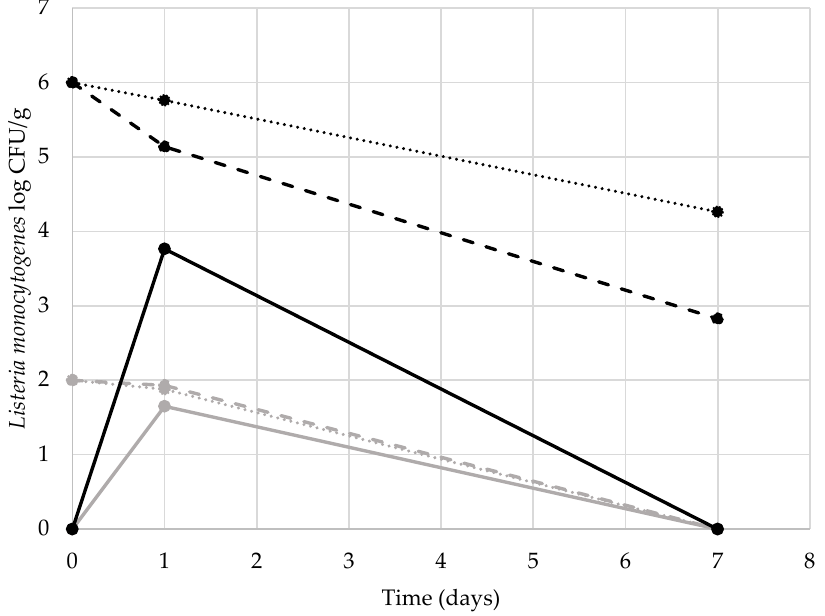
Figure 2. Listeria monocytogenes counts in the substrates (with and without larvae) and larvae. Listeria monocytogenes inocula of 2 log CFU/g and 6 log CFU/g, respectively, in grey and black. The dotted lines represent the counts in the substrate without the larvae, the dashed lines represent the counts in the substrate with the larvae, and the full lines represent the counts of the larvae.